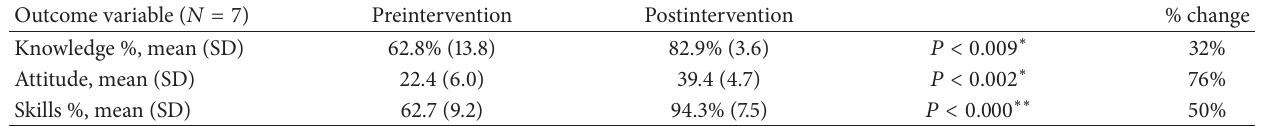
Table 5: Comparison of outcome measures before and after educative